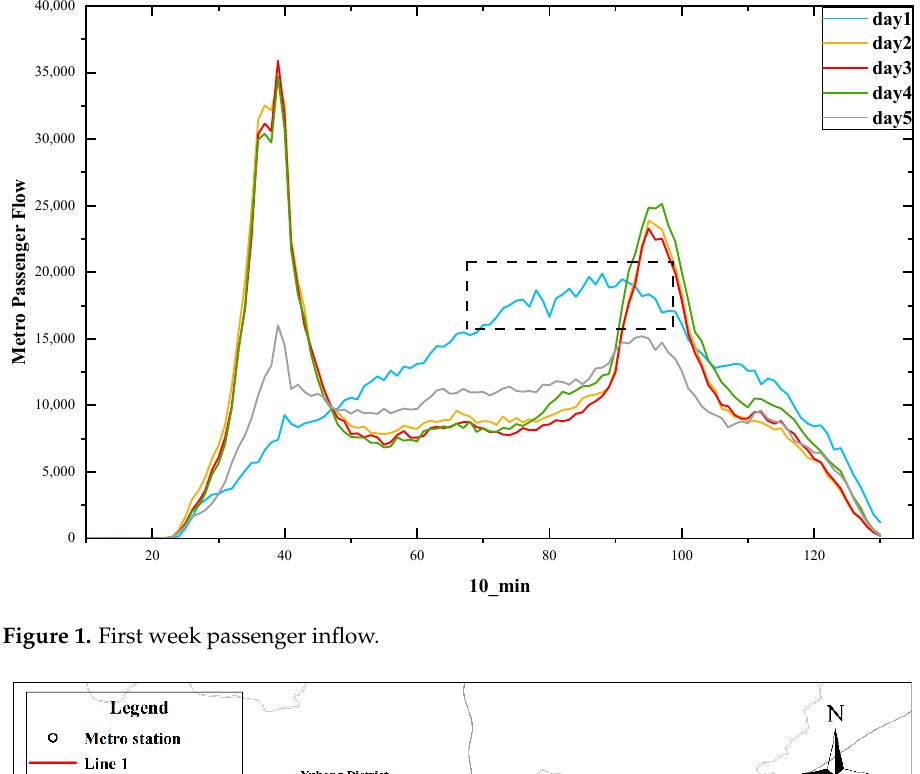
Figure 1. First week passenger inflow.